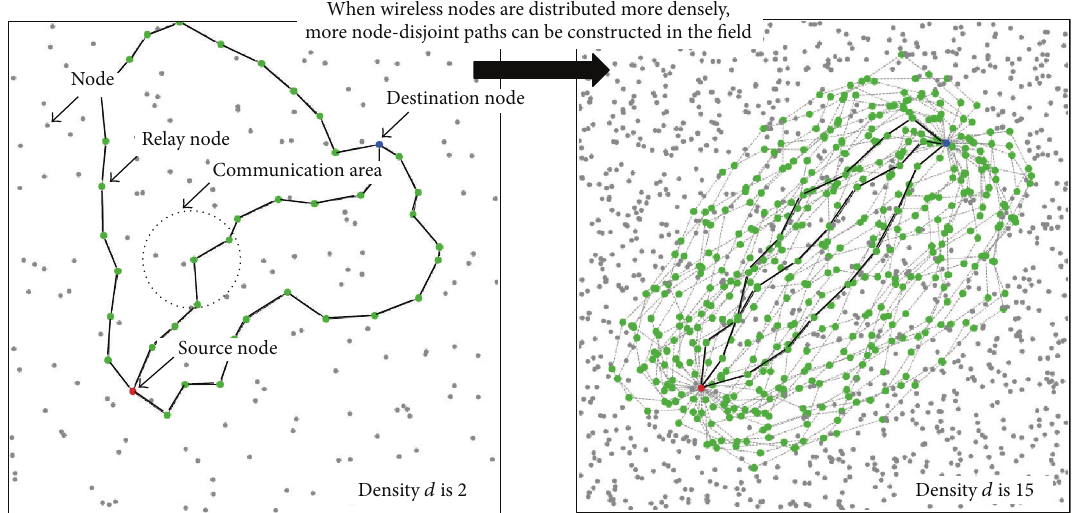
Figure 1: Influence of node density 𝑑 on node-disjoint paths between the source node and the destination node.